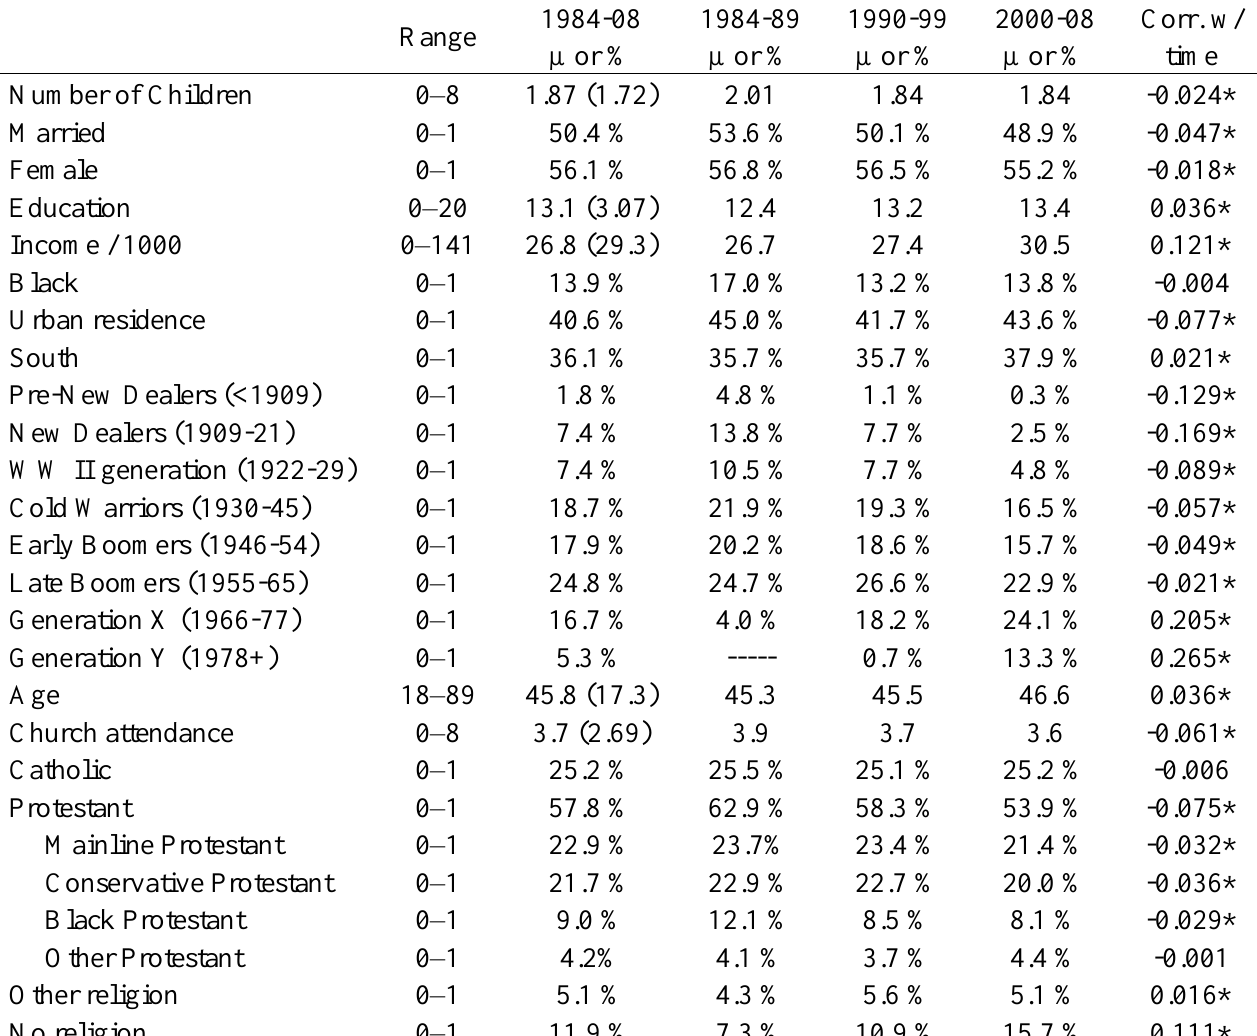
Table 1. Descriptive Statistics for all Variables in the Models, 1984-2008 (N =